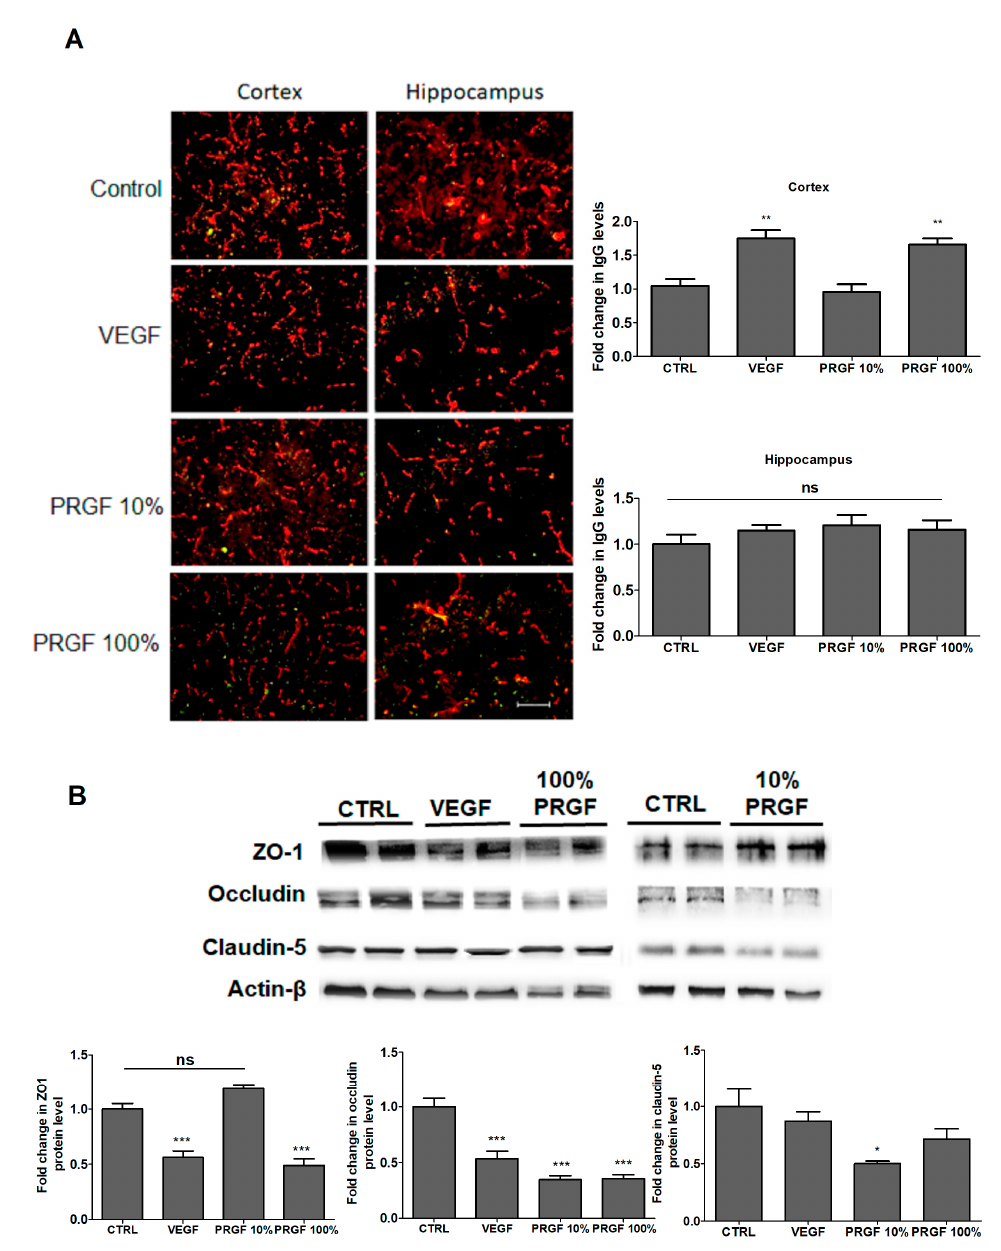
Figure 4. Effect of VEGF (100 pg/mL) and PRGF (10 and 100%) on BBB tightness in 5xFAD mice. ( A ) Representative brain sections stained with collagen antibody (red) to detect microvessels and IgG antibody (green) to detect BBB leakiness demonstrated by an increased IgG extravasation in the hippocampi and cortexes of mice treated with VEGF and PRGF compared to control, with their optical density quantitation. ( B ) Representative blots and densitometry analysis of ZO1, occludin and claudin-5 in microvessels isolated from 5xFAD mice brains. Data are presented as mean ± SEM ( n = 7 mice/group). * p < 0.05, ** p < 0.01, *** p < 0.001 compared to control (CTRL) group; ns is not significant. The white scale bar indicates a 50 µm length.